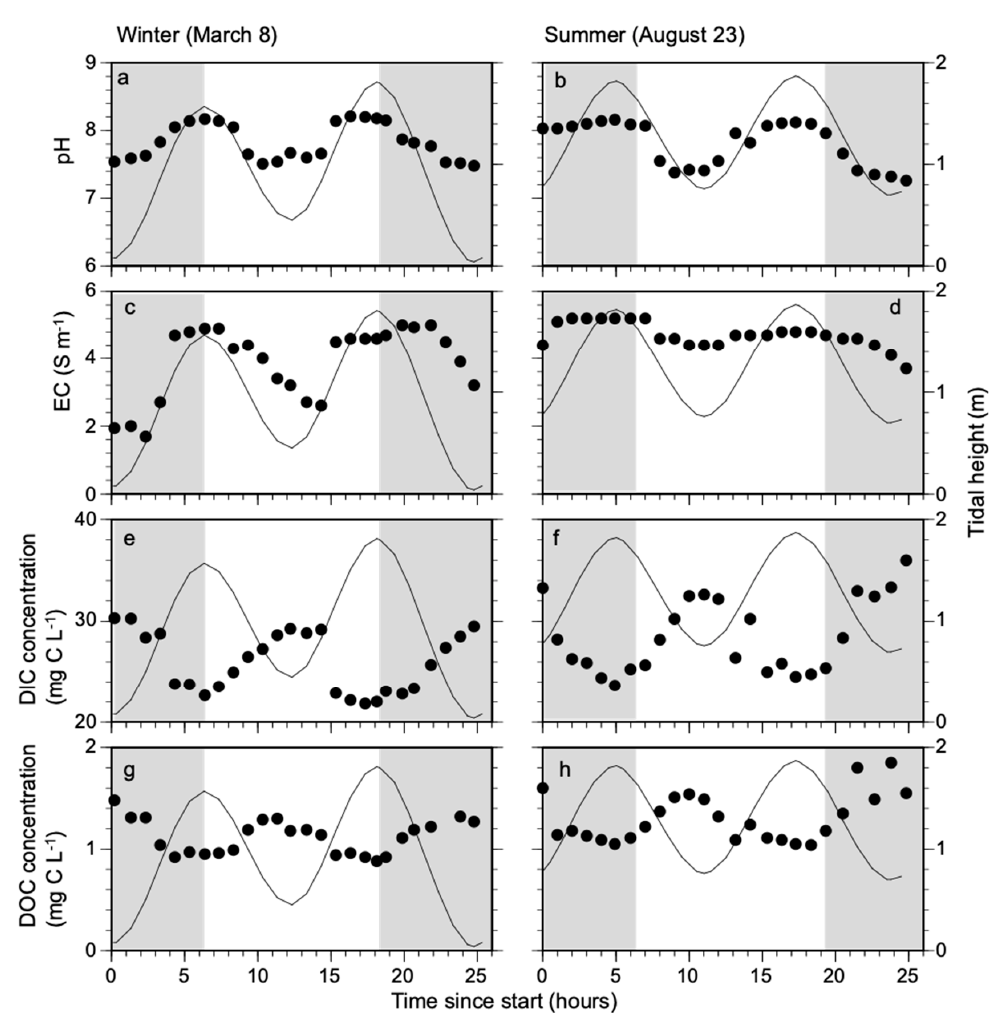
Figure 2. Tidal variations of pH ( a , b ), electric conductivity (EC) ( c , d ), dissolved inorganic carbon (DIC) ( e , f ), and dissolved organic carbon (DOC) ( g , h ) concentrations at the river mouth in a small estuarine mangrove during the time course. The line indicates the tidal height (m) obtained from the Japan Meteorological Agency (JMA). Shaded areas show the nighttime.